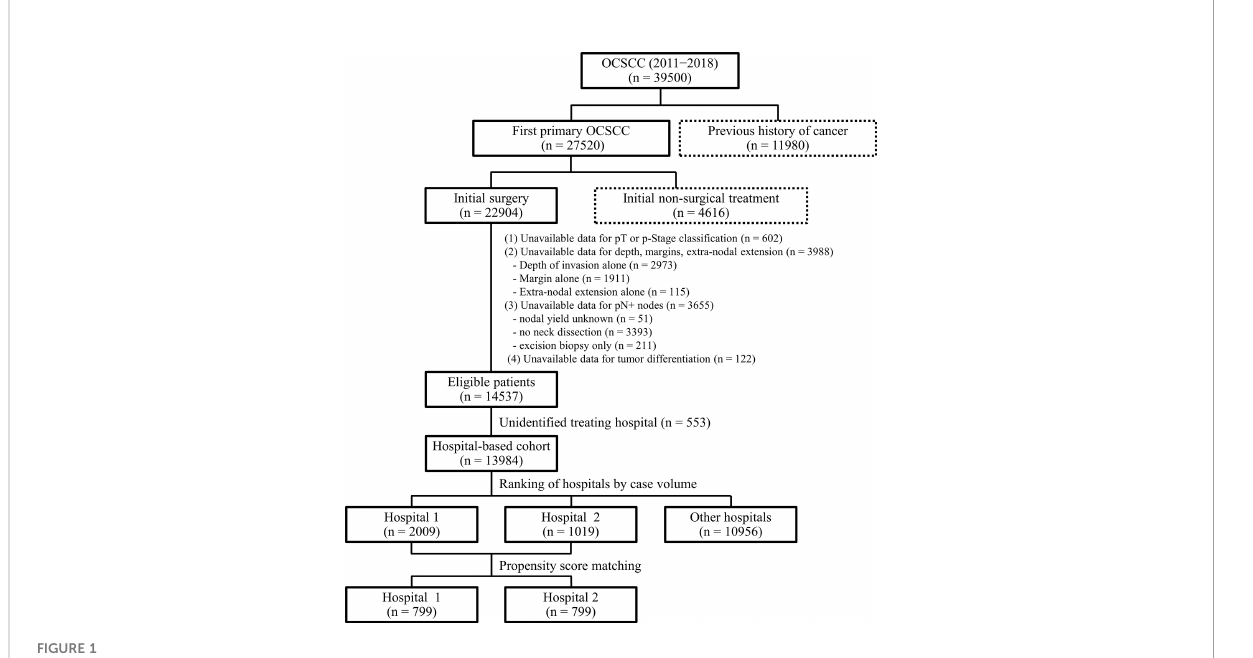
FIGURE 1 Flow of patients through the